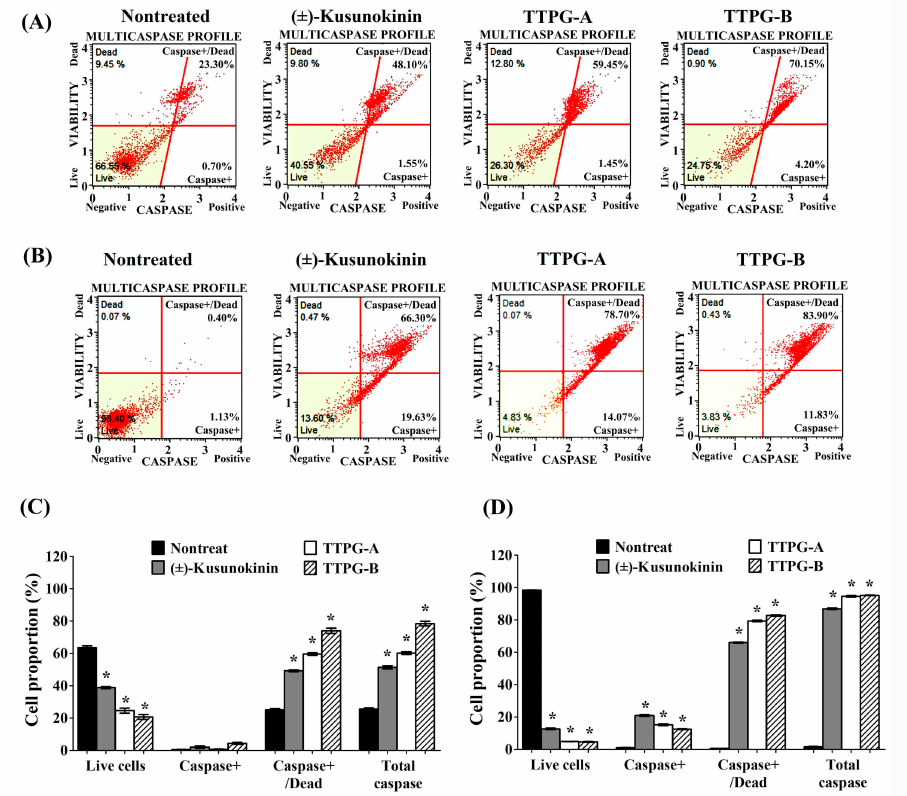
Figure 4. ( ± )-TTPG-A and ( ± )-TTPG-B enhanced the multi-caspase activity. ( A ) The concentrations of ( ± )-kusunokinin, ( ± )-TTPG-A and ( ± )-TTPG-B used in this treatment were 4.47, 0.07 and 0.01 µ M, respectively, for 72 h. Non-treated cells served as control. ( B ) KKU-M213 cells were exposed to 0.15 µ M of ( ± )-kusunokinin, ( ± )-TTPG-A and ( ± )-TTPG-B for 48 h. After treatment, cells were analyzed for the activities of multiple caspases (caspase-1, -3, -4, -5, -6, -7, -8, and -9), using the Muse ®® Multi Caspase assay and 7-AAD (dead-cell kit). Fluorescence intensity for multi-caspase was indicated on the x-axis, and 7-AAD was indicated on the y-axis. The populations of stained/unstained cells were indicated in each quadrant. Four populations of cells were distinguished for live cells (lower left for caspase( − ) and 7-AAD( − )), caspase activity (lower right for caspase(+) and 7-AAD( − )), late stage of caspase activity (upper right for caspase(+) and 7-AAD(+)) and necrotic cells (upper left for caspase( − ) and 7-AAD(+)). ( C , D ) The graph represents the average percentages ± SD of live, caspase+, caspase+/dead and total caspase from three independent experiments. The statistical analysis of the data was evaluated using Student’s t -test. * Indicates p values less than 0.05 which were considered as significant differences, compared with the control